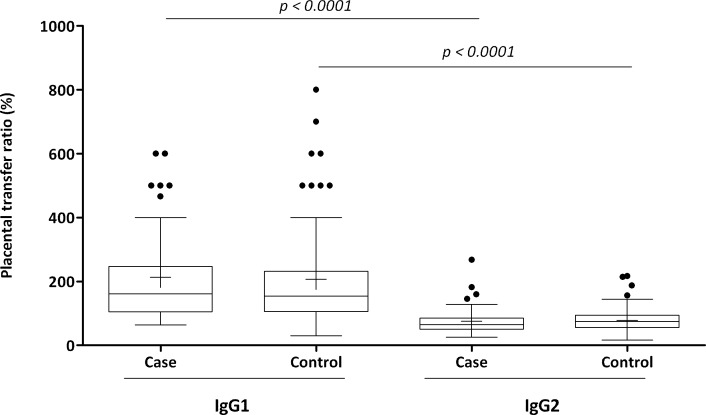
Placental transfer ratios (%) of anti-S. aureus IgG1 and IgG2 from case and control groups. Comparison of the data is presented as box and whisker plots. The box represents the 25th–75th percentiles, and the median is represented by the line within the box. The whiskers represent the 5th–95th percentiles.